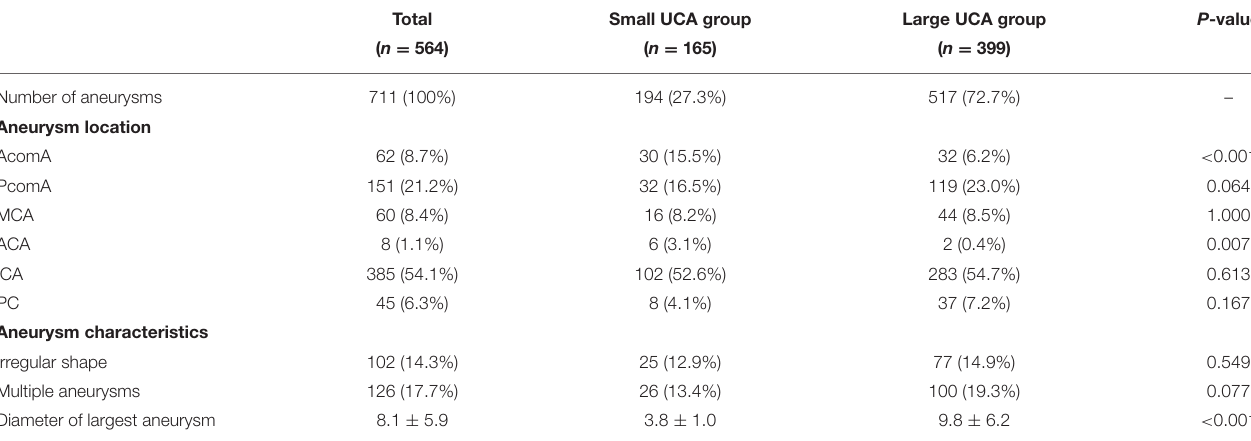
TABLE 2 | Location and characteristics of UCAs, divided into small and large UCA